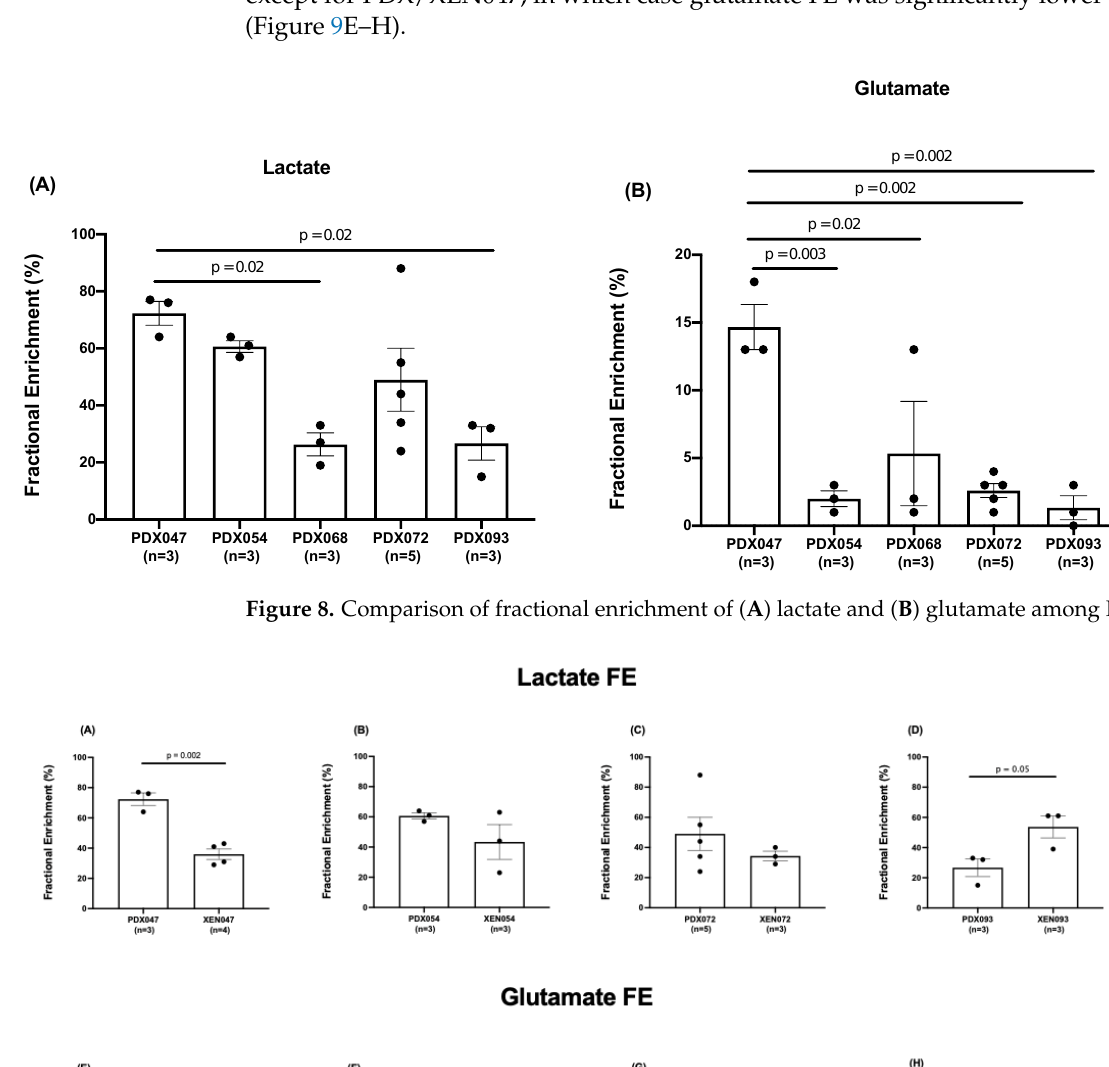
Figure 9. Comparison of fractional enrichment of ( A – D ) lactate and ( E – H ) glutamate between PDX and corresponding XEN. Statistical test used: unpaired t- test with Welch’s correction.